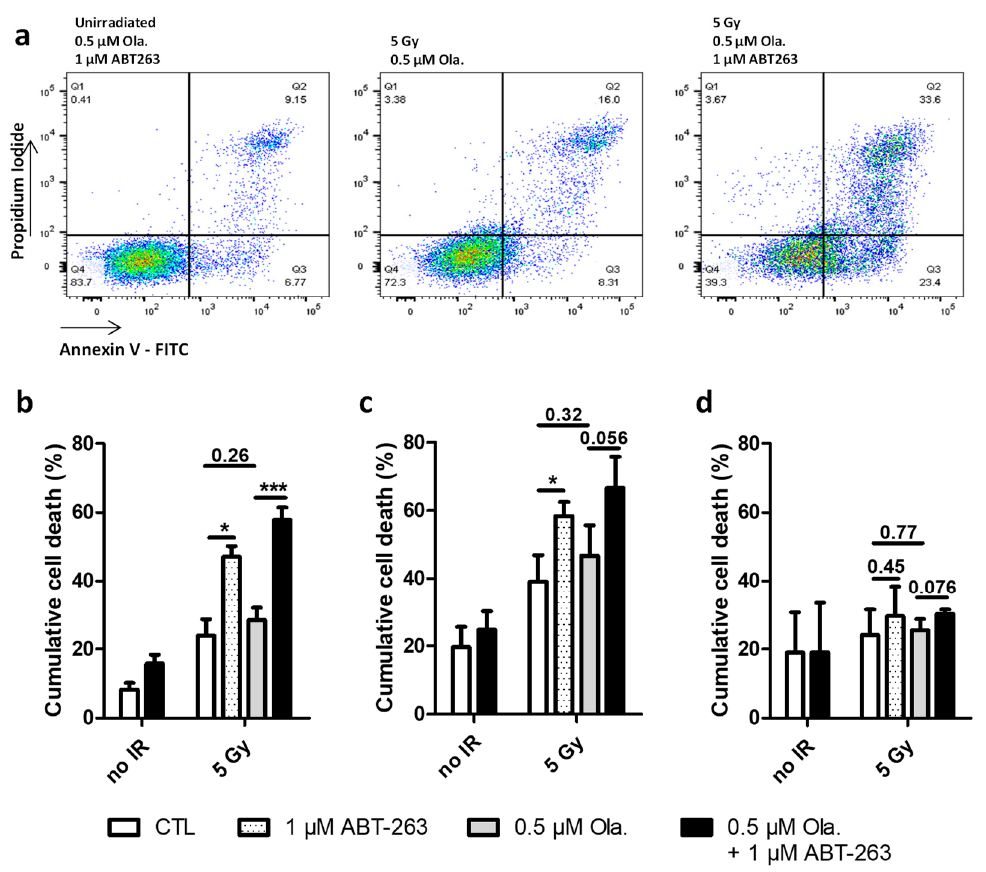
Figure 3. ABT-263 can induce cell death in cell lines displaying radiation-induced senescence. A549, HCT-116 and KP4 cells were irradiated with 5 Gy X-rays with or without 0.5 µM of Olaparib. The medium was replaced 22 h after irradiation, and 1 µM of ABT-263 was added. ( a ) Representative flow cytometry results for Annexin V assessment in A549 cells 72 h after irradiation. ( b – d ) Cumulative cell death 72 h after X-rays (( b ): A549 cells; ( c ): HCT-116 cells, ( d ): KP4 cells). At least three independent experiments were performed, and data are presented as mean ± 1 SD. Unpaired t -tests were performed (*: p < 0.05; ***: p < 0.001) for CTL vs. ABT, CTL vs. Ola and Ola vs. Ola + ABT. PARP cleavage was analyzed by Western blot 6 days post-irradiation in A549 cells exposed to 5 Gy X-rays (Supplemental Figure S3a,b). The ratio of the cleaved over full length forms of PARP was higher in irradiated cells in the presence of ABT-263, especially when combined with Olaparib. A slight increase in Bcl-XL mRNA levels 3 and 6 days after X-ray or proton irradiation was observed in the presence of Olaparib (Supplemental Fig- ure S3c–f). In both cases, the addition of ABT-263 was able to reduce, to a small extent, this increase. These results showed that ABT-263 was able to promote cell death after irradiation in cell lines displaying radiation-induced senescence. 3.4. Non-Toxic Combination of ABT-263 and Olaparib Can Synergize after X-ray and Proton Irradiation to Increase Clonogenic Cell Death Clonogenic fractions were assessed after 3 and 5 Gy X-ray irradiation in A549, HCT- 116 and KP4 cell lines as well as after 1 and 2.5 Gy proton irradiation for A549 cells (Figure 4). For all cell lines, the combination of Olaparib and ABT-263 led to limited toxicity in un- irradiated cells as shown in Figure 4 (values are presented in Table S2). HCT-116 cells were more radiosensitive than A549 and KP4 cells.